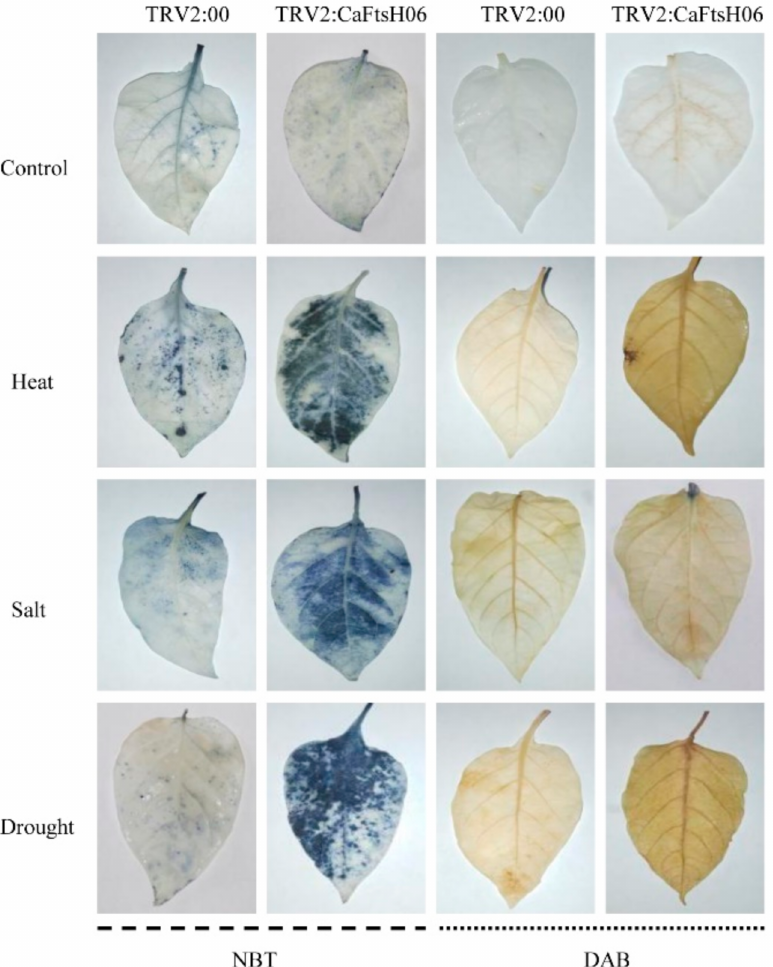
Figure 9. Histochemical staining of pepper leaves under heat, salt, and osmotic stresses in the CaFtsH06 -silenced and control pepper plants. The NBT and DAB staining in CaFtsH06 -silenced plant leaves after heat, salt, and drought stress treatments revealed darker stanning patterns than the control plants, indicating the accumulation of · O 2 − and H 2 O 2 ,